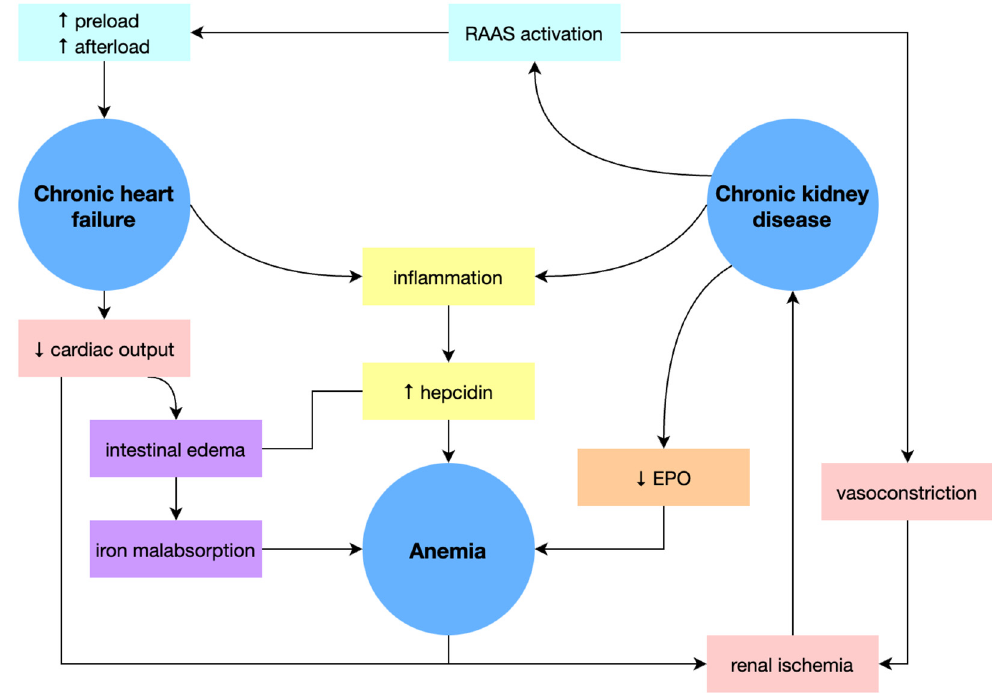
Figure 2. Physiopathology of cardio-renal anemia syndrome. EPO, erythropoietin. RAAS, renin- ↑ = elevated value, ↓ = decreased angiotensin-aldosterone system. ↑ = elevated value, ↓ = decreased value. angiotensin-aldosterone system.